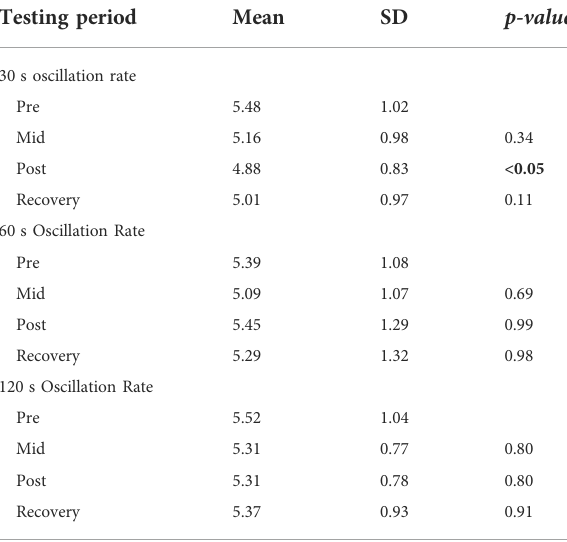
TABLE 4 The in fl uence of 30 s oscillations of 80/20 and 30/70 O 2 /N 2 concentrations on lung diffusion